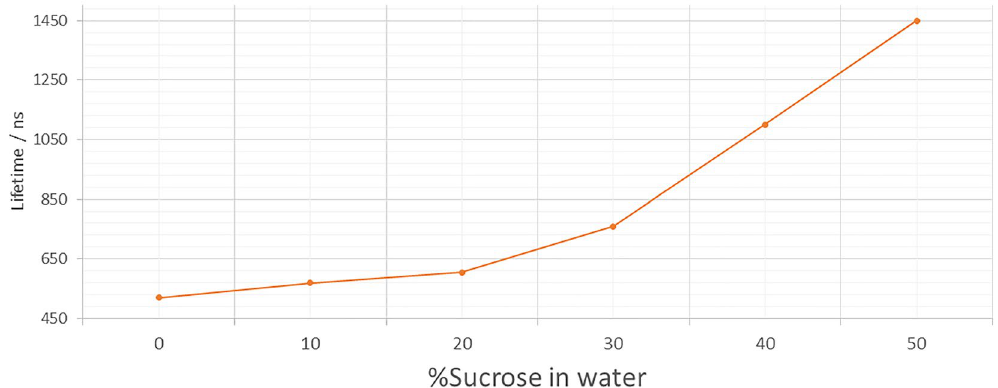
Figure 4. Viscosity dependence of Pt[L]Cl (50–100 µM) phosphorescence lifetime in water with varying sucrose concentration. Error margin is with 10% standard